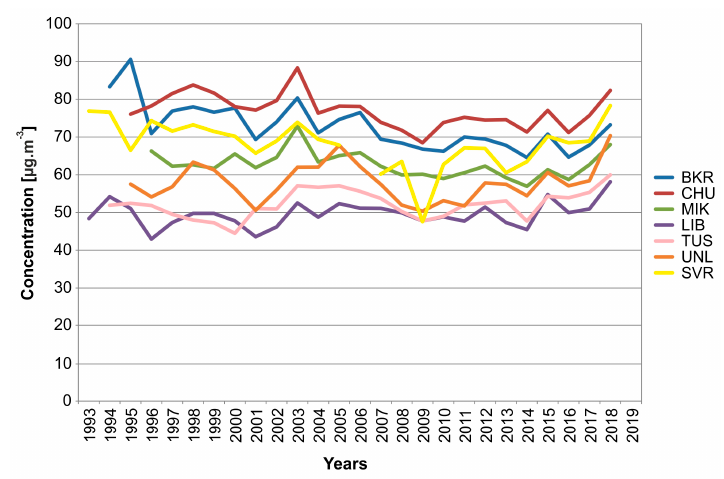
Figure 11. Trends in ambient annual mean O 3 concentrations at selected sites (see Table 1, Figure 2), 1993–2018, based on CHMI data.